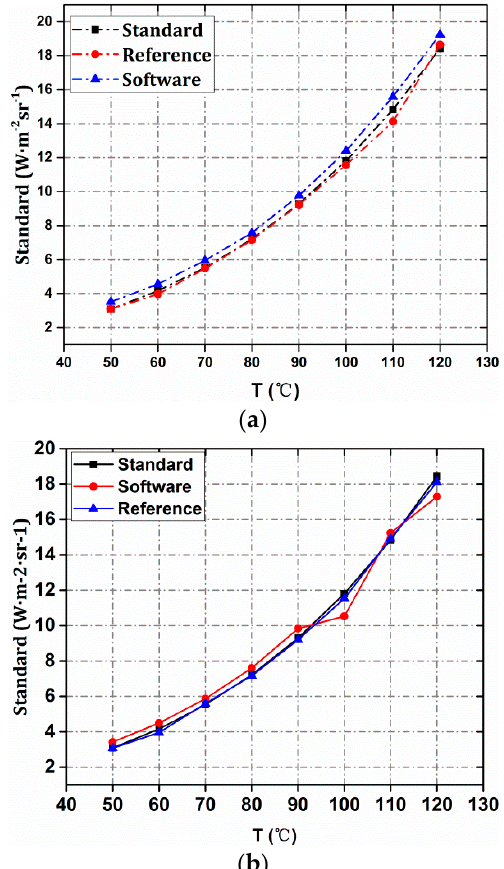
Figure 6. The precison result of radiometry. ( a ) The comparative result between conventional and the proposed method at 2000 μ s; ( b ) The comparative result between conventional and the proposed method at 3000 μ s.